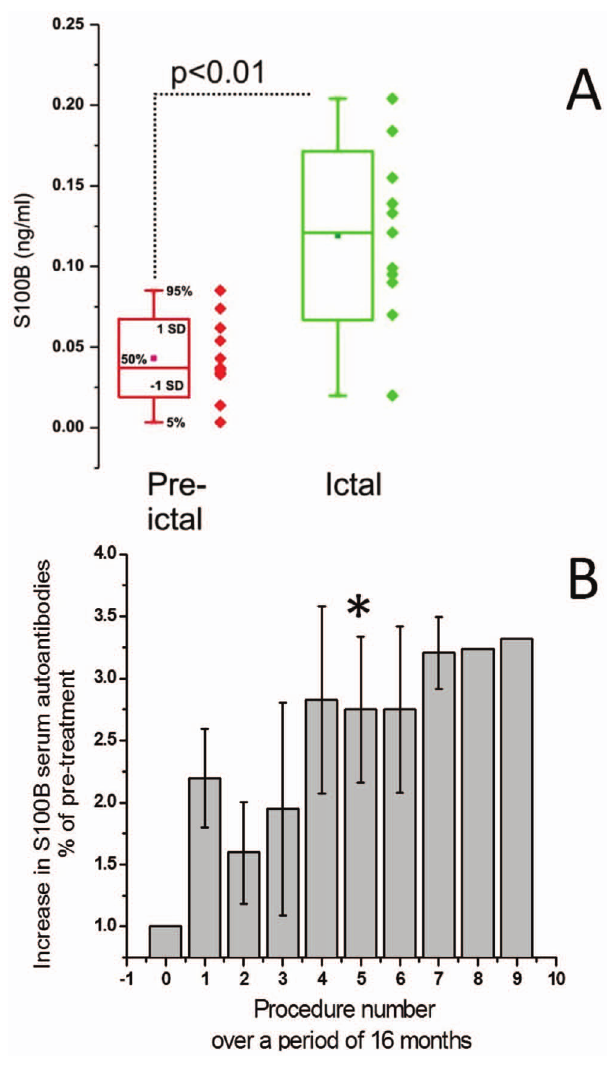
Figure 6. BBBD precedes clinical seizures and result in the formation of S100B autoantibodies. ( A ) Data were obtained by performing serum analysis in patients affected by seizures who underwent monitoring in the Epilepsy unit. Blood was drawn as soon as changes consistent with seizure development were observed. These consisted of a combination of behavioral and EEG changes. False positive samples (blood drawn, no subsequent seizure within 15 minutes) were discarded. Pre-ictal samples refer to blood drawn before